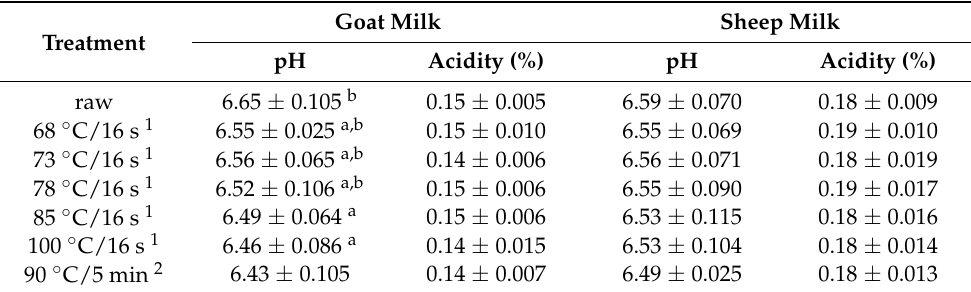
Table 1. pH and titratable acidity (% lactic acid) of heat-treated homogenized goat and sheep milk; means ± standard deviation. Different letters indicate significant differences (LSD, p < 0.05) between the means of different heat